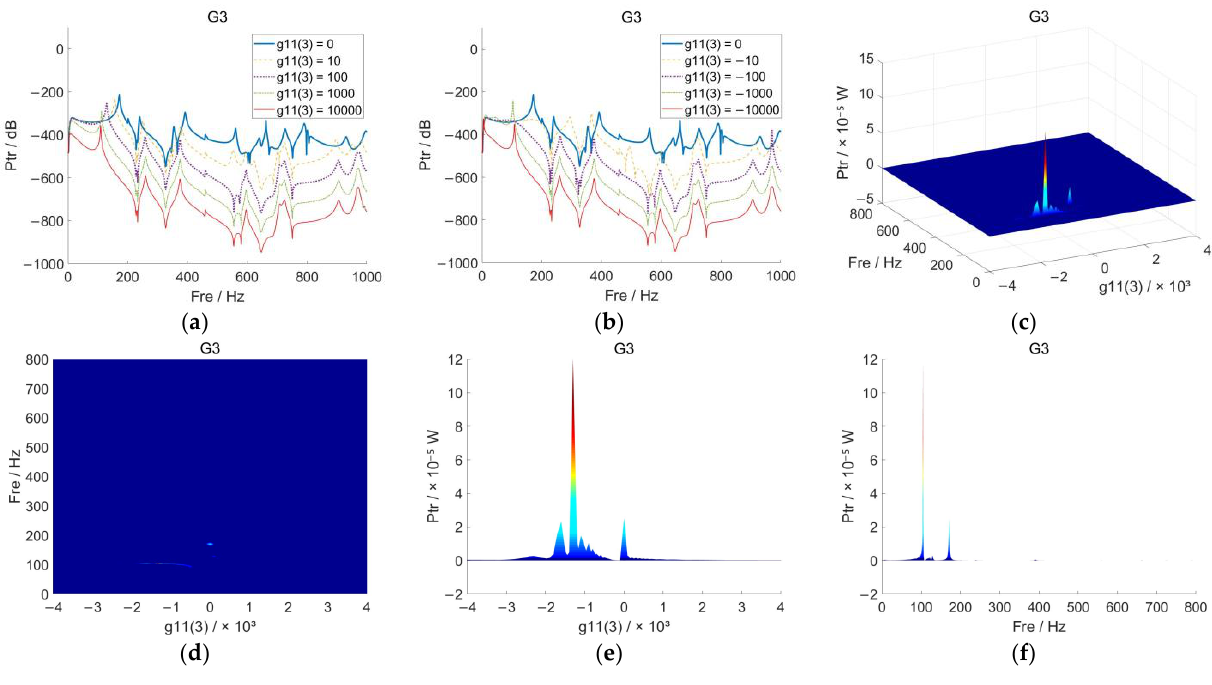
( 3 ) P under the absolute acceleration feedback g — Fre — Figure 4. The 2D view and 3D view of ( ) 3 Figure 4. The 2D view and 3D view of g — Fre — P tr under the absolute acceleration feedback 11 tr 11 ( 3 ) P curves under control method ( ( ) ( ,  − , the step size is set to 10): ( a ) comparison of ∈ (cid:0) − 10 4 , 10 4 (cid:1) , the step size is set to 10): ( a ) comparison of P tr curves under control method ( g tr 11 ( 3 ) ( ) 3 > 0; ( b ) comparison of P tr curves under g ( 3 ) < 0; ( c ) the 3D view of P tr curve under continuous g P curves under ( ) 3 P curve under continuous 0 g  ; ( b ) comparison of 0 g  ; ( c ) the 3D view of 11 11 11 11 tr tr ( 3 ) variation of g ; ( d ) X-Y plane view; ( e ) X-Z plane view; ( f ) Y-Z plane g ; ( d ) X-Y plane view; ( e ) X-Z plane view; ( f ) Y-Z plane view. variation of ( ) 3 11 11